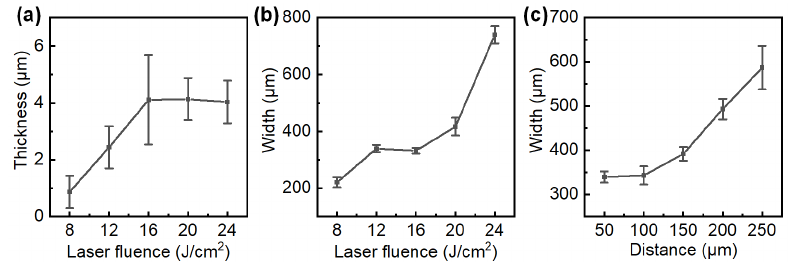
Figure 3. ( a ) Film thickness, and ( b ) line width of LTNS as a function of laser fluence. ( c ) Line width as a function of transfer distance between the donor film and receiver substrate.